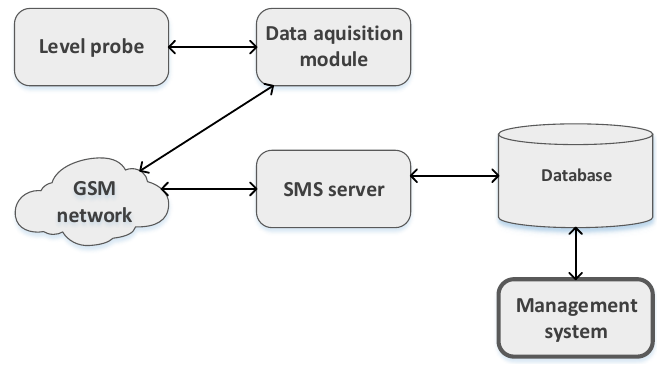
Figure 1. Grease boxes monitoring and management system.